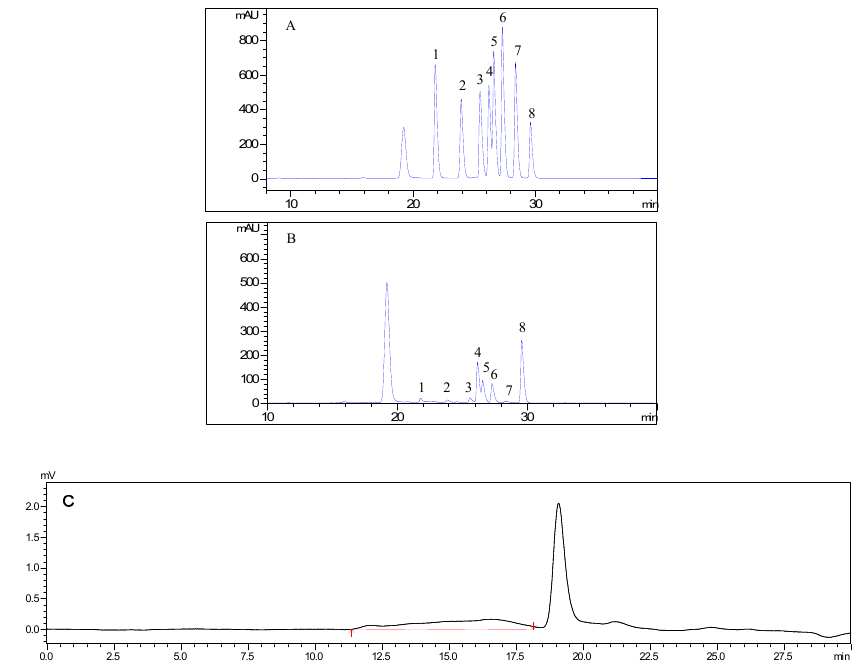
Figure 1. HPLC results of monosaccharide composition analysis of the standards ( A ) and the polysaccharides from Athyrium multidentatum (Doll.) Ching ( B ), and result of molecular weight analysis ( C ). 1, Man; 2, Rha; 3, Glc A; 4, Glc; 5, Gal; 6, Ara; 7, Fuc; 8, Rib.